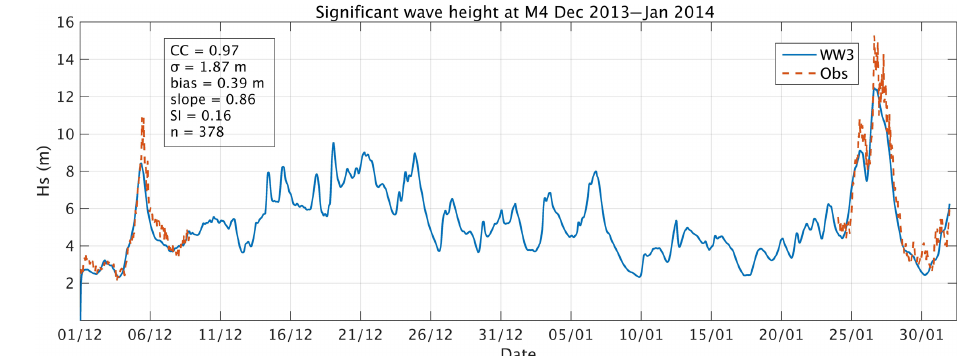
Figure 4. Timeseries of significant wave height for December 2013 and January 2014 comparing observations from the the Irish Weather Buoy Network M4 buoy (55, − 9.99) and modelled values. Note that the M4 buoy was non-operational for most of the period under evaluation. In the upper left corner we provided the following statistical parameters: Correlation coefficient (CC), standard deviation ( σ ), bias, slope, scatter index (SI), and the number of records ( n ).